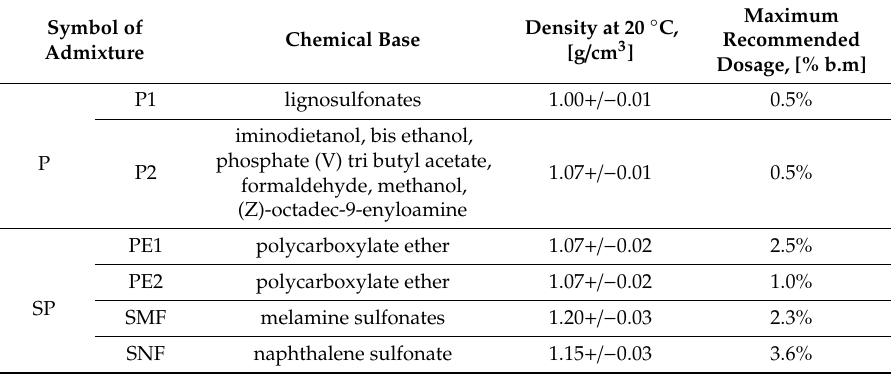
Figure 8. Morphology of calcareous fly ash grains batch C (magnification of 1500 times). Table 4. The type, chemical base, density and volume of chemical admixtures. Date obtained from the manufacturer of admixture.